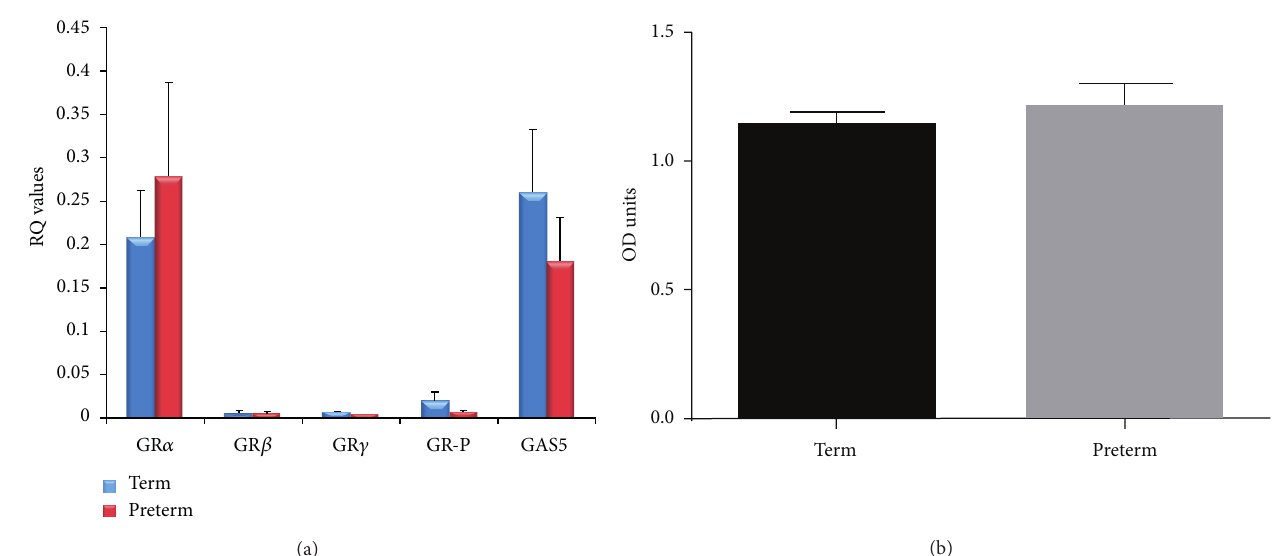
Figure 1: (a) Expression of GR 𝛼 , GR 𝛽 , GR 𝛾 , GR-P, and GAS5 in term (blue; 𝑛 = 13 ) and preterm (red; 𝑛 = 10 ) placentas. (b) Protein expression of GRs correcting over GAPDH, in term ( 𝑛 = 4 ) and preterm ( 𝑛 = 3 ) placentas.